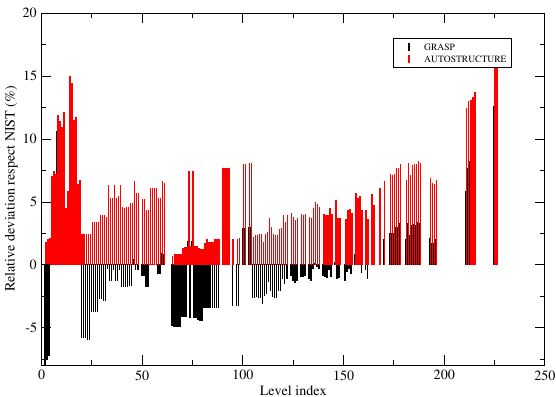
Figure 1. Relative deviation (percentage) of the calculated energy values with respect to the recommended data of NIST. Black bars: GRASP; red bars AUTOSTRUCTURE .